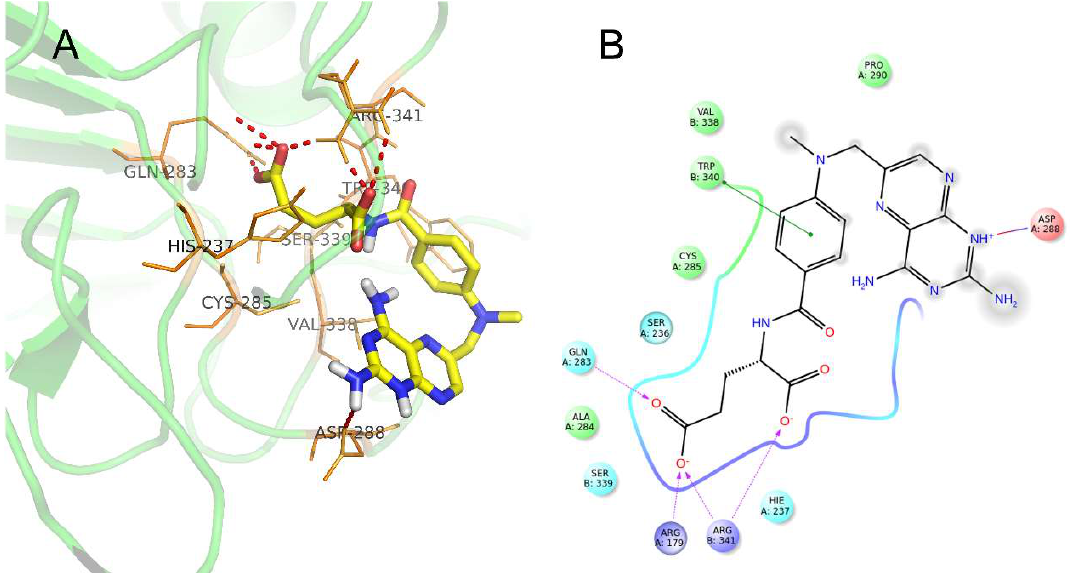
Figure 12. Docking interaction modes of methotrexate within the binding pockets of caspase-1. ( A ) The 3-dimensional polar contacts between methotrexate and caspase-1. The light green cartoon is caspase-1 prepared by pymol. The red dotted line is the polar contacts. The thin orange sticks are the interactive residues of caspase-1. The thick sticks are the methotrexate (Yellow are carbon atoms, Blue are nitrogen atoms, Red are oxygen atoms, White are some of the hydrogen atoms). ( B ) two-dimensional display of the interaction between the ligand and the protein (The colorful balls at the edge are related amino acids. Polar contacts are displayed with different lines. Purple dotted lines represent the polar contacts with Oxygen anion, green line represents with Benzene, blue red line represents with ammonium).